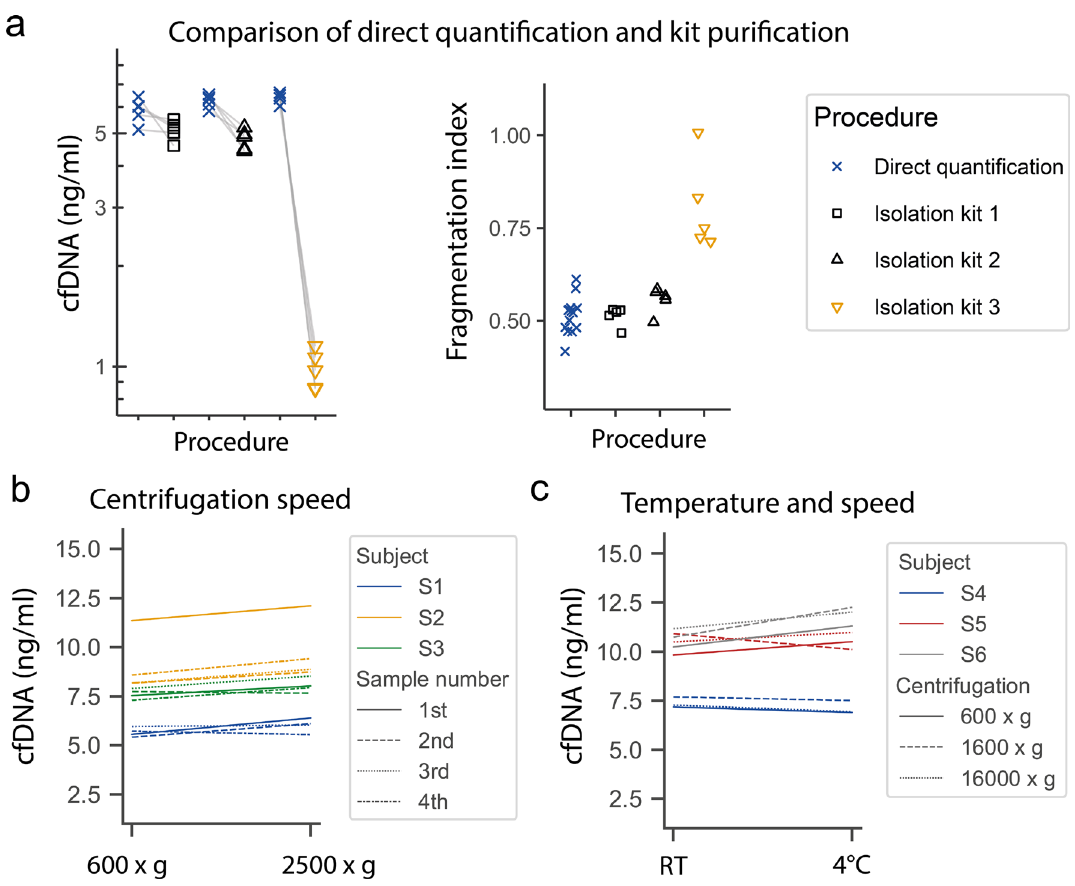
Figure 3. Direct quantification of cfDNA compared to DNA isolation and influence of centrifugation speed and temperature on cfDNA concentration. ( a ) Plasma aliquots of the same sample were directly quantified or analyzed after DNA isolation with custom DNA isolation kits, to determine the cfDNA concentration (left) and the fragmentation index (right). ( b ) From different subjects (S1–S3) four samples were consecutively collected in different blood containers, centrifuged at 600 × g or 2500 × g for 10 min and measured with the L1PA2_90bp assay. ( c ) From each subject a single blood sample was collected and centrifuged consecutively at indicated speed at 4 °C or room temperature (RT) and measured in duplicate, mean values are illustrated. The figures were produced using the Python (v3.7.6) 28 libraries matplotlib (v3.1.1) 29 , and seaborn (v0.9.0) 30